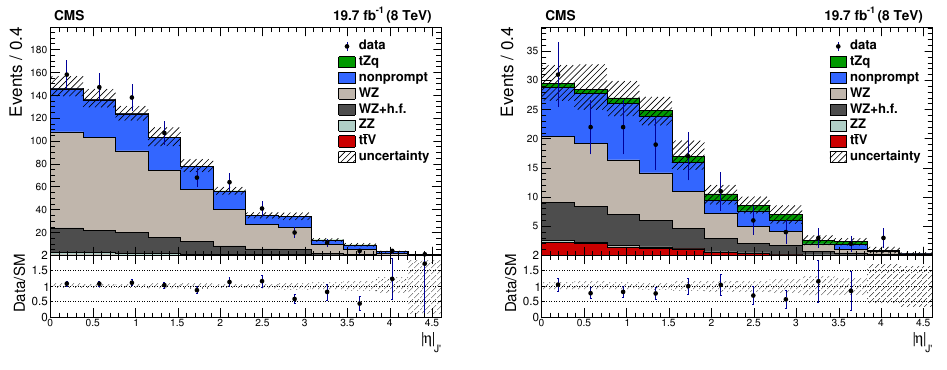
Figure 7 . Data-to-prediction comparisons after performing the (cid:12)t for the j (cid:17) j distribution of the recoiling jet in the control region (left), and the signal region (right). The four lepton channels are combined. The lower panels show the ratio between observed and predicted yields, including the total uncertainty on the prediction.